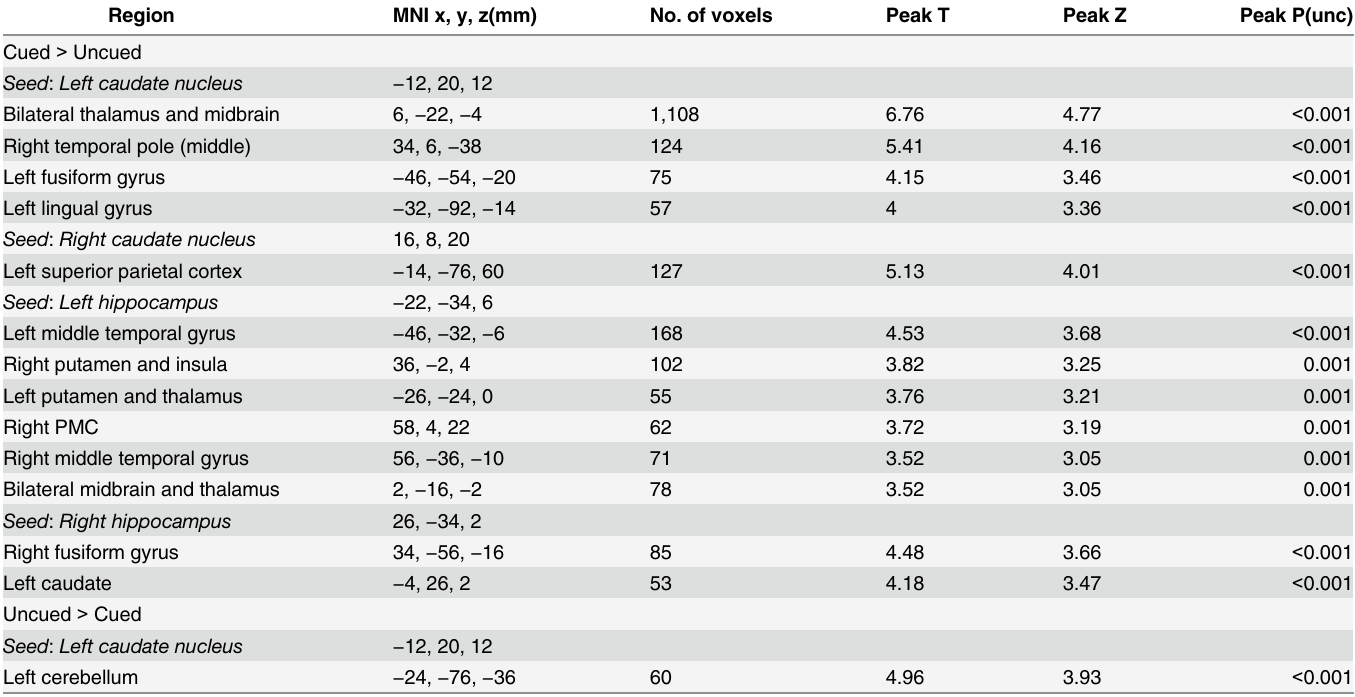
Table 5. Coordinates of local maxima for brain regions showing increased (cued > uncued) and decreased (uncued > cued) functional connectivity (PPI) after TMR ( n = 20). Region MNI x, y, z(mm) No. of voxels Peak T Peak Z Peak